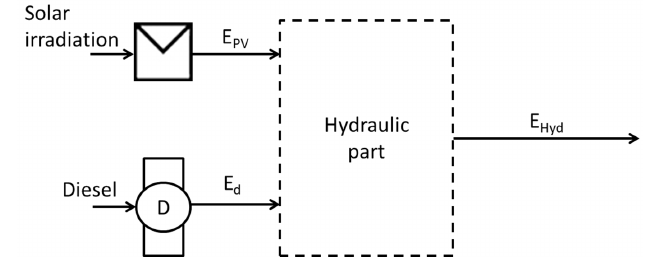
Figure 8. Energy flows involved in a hybrid PV-diesel irrigation system.